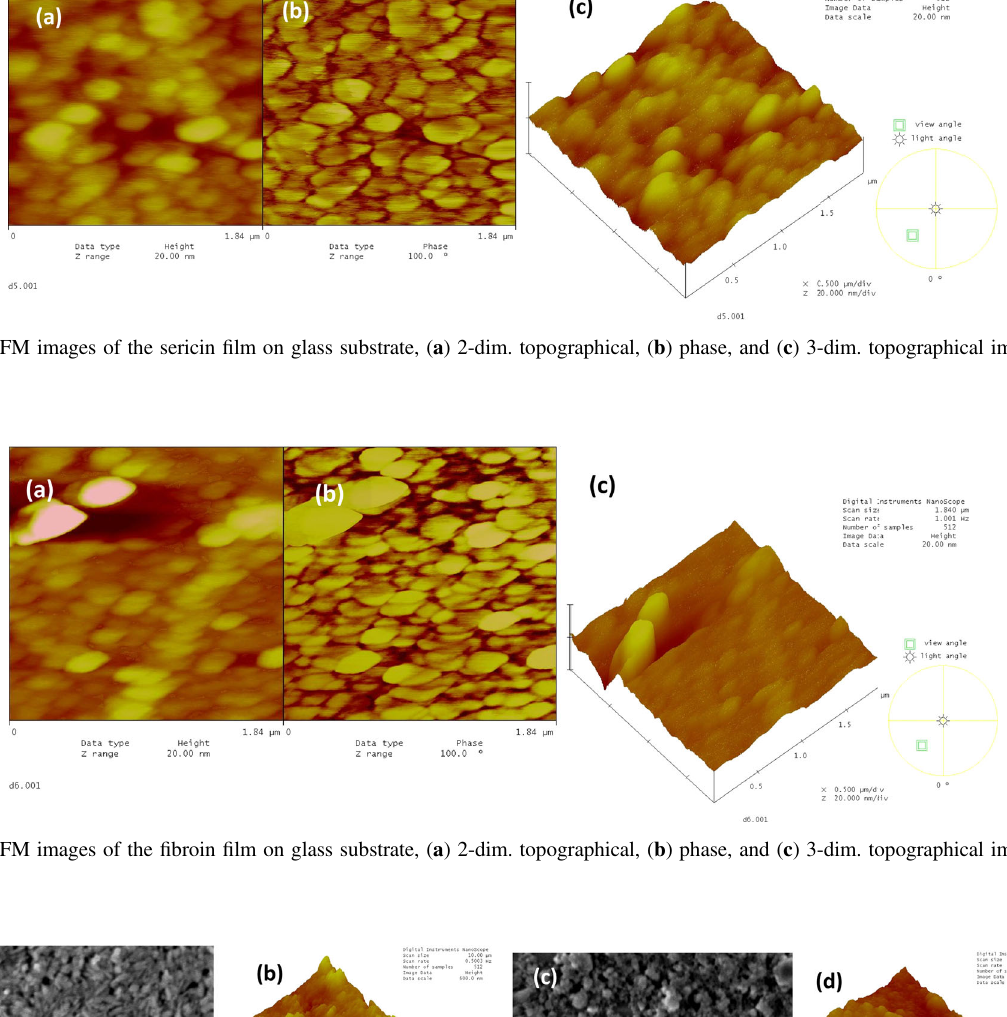
topographical image of c-HAp fi lm, 10 × 10 μ m, ( c ) the SEM image of m-HAp fi lm, 50,000x ( d ) the AFM 3-dim. topographical image of m-HAp fi lm, 10 × 10 μ